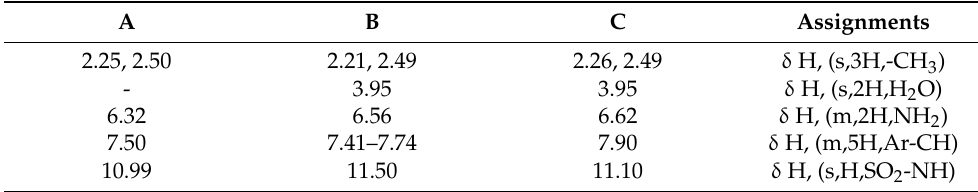
Table 5. 1 H NMR data (ppm) and tentative transitions for (A) sulfamethoxazole; (B) [Pt(smx)(H 2 O)Cl 3